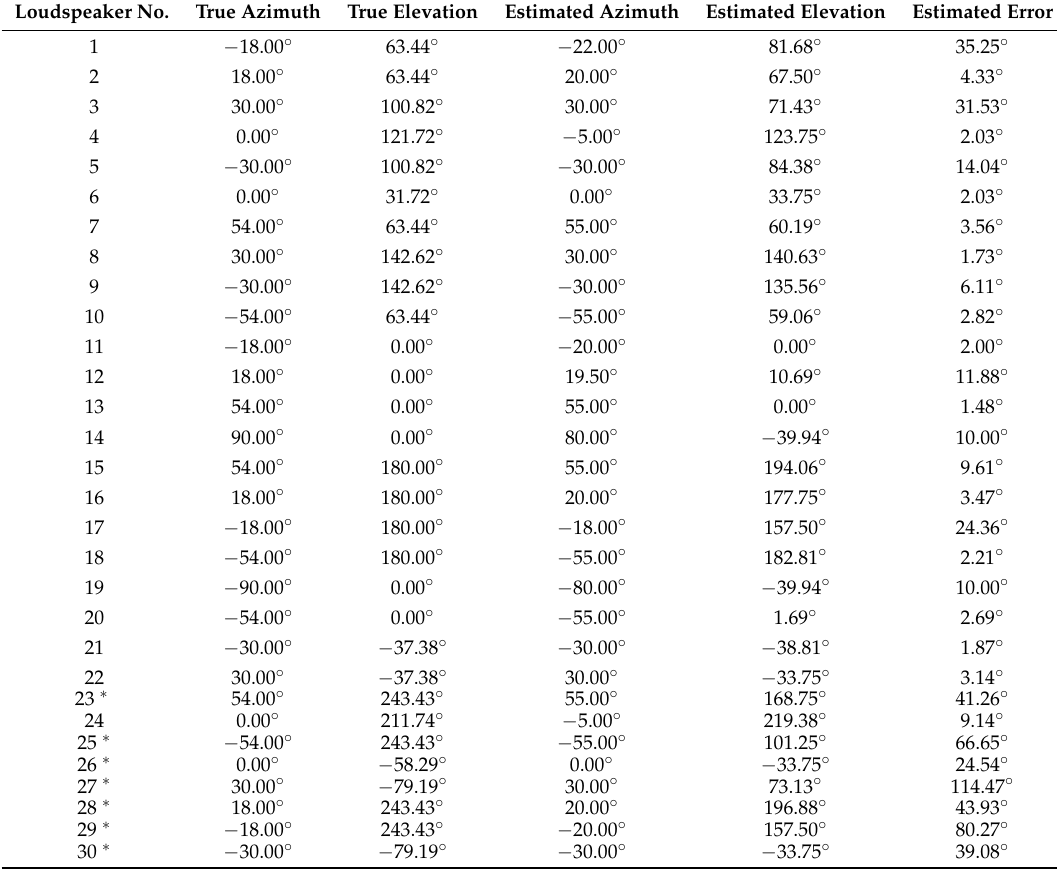
Table 4. To performance of the passive model. The ground truth loudspeaker locations are represented in Θ IP